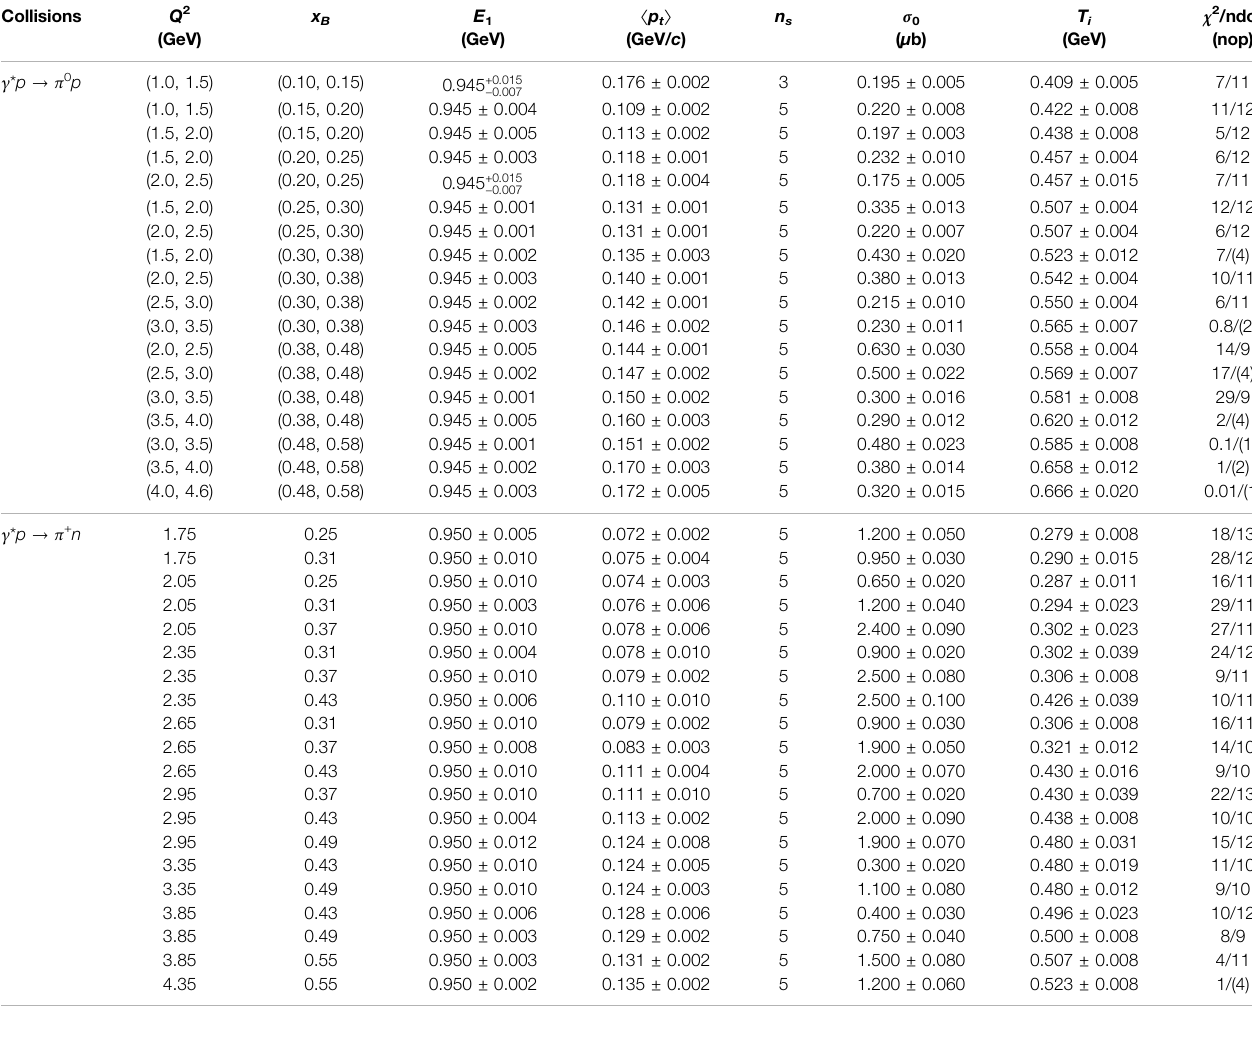
TABLE 1| Values of E 1 , 〈 p t 〉 , n s , σ 0 , T i ,and χ 2 /ndofcorresponding tothecurvesin Figures1 , 2 ,where n s isconstrainedtobeintegerwithuncertainty of0whichisnotlisted inthetable.Thenumberofparametersisalways4whichincludes E 1 , 〈 p t 〉 , n s ,and σ 0 .Inthecaseofndofbeinglessthanorequaltothenumberofparameters,weobtain the curve from a “ prediction ” or extrapolation based on other reasonable fi ts, and show the corresponding nop in a bracket to replace ndof. The value of χ 2 is rounded to an integer, or one signi fi cant digit if the integer is